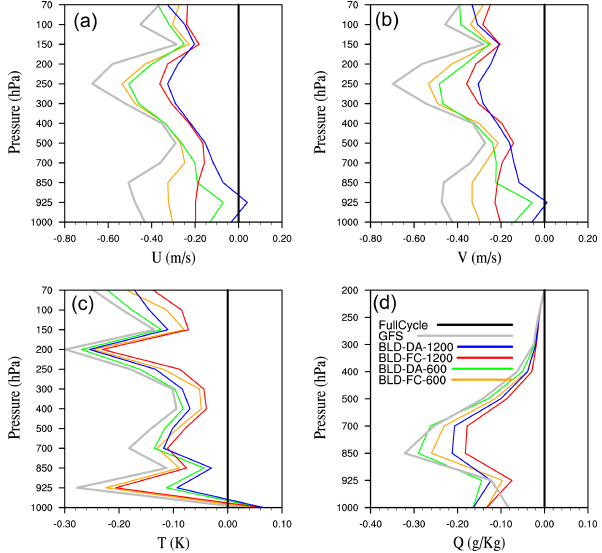
Figure 6. RMSD reduction compared to FullCycle at analysis time.